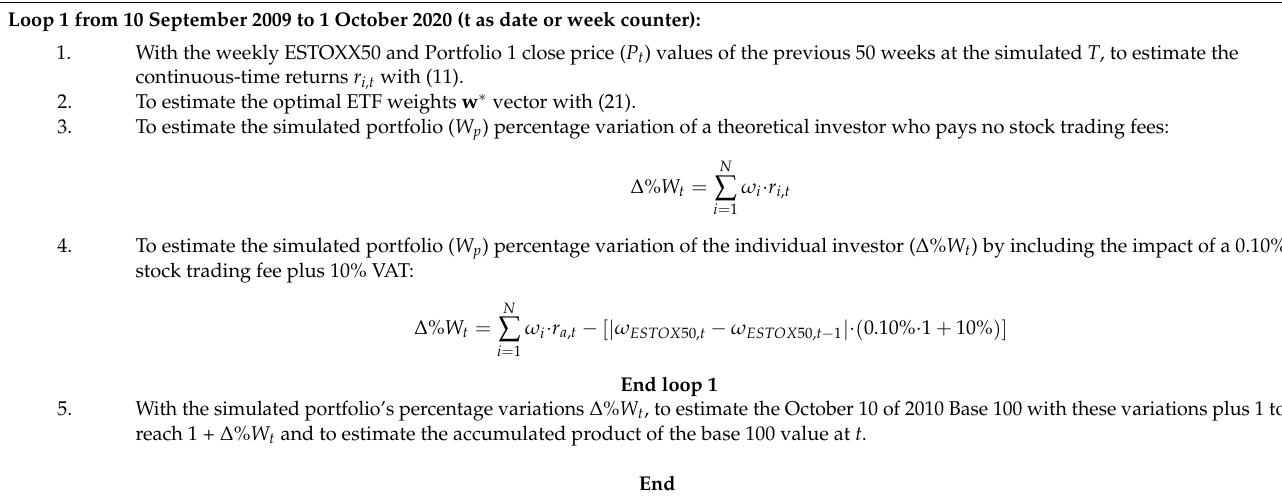
Algorithm 3 The steps executed to simulate the performance of a theoretical investor who allocates his/her capital in a portfolio invested in a theoretical zero tracking-error ESTOXX50 portfolio ETF and another theoretical one invested in portfolio 1 of Table 2.